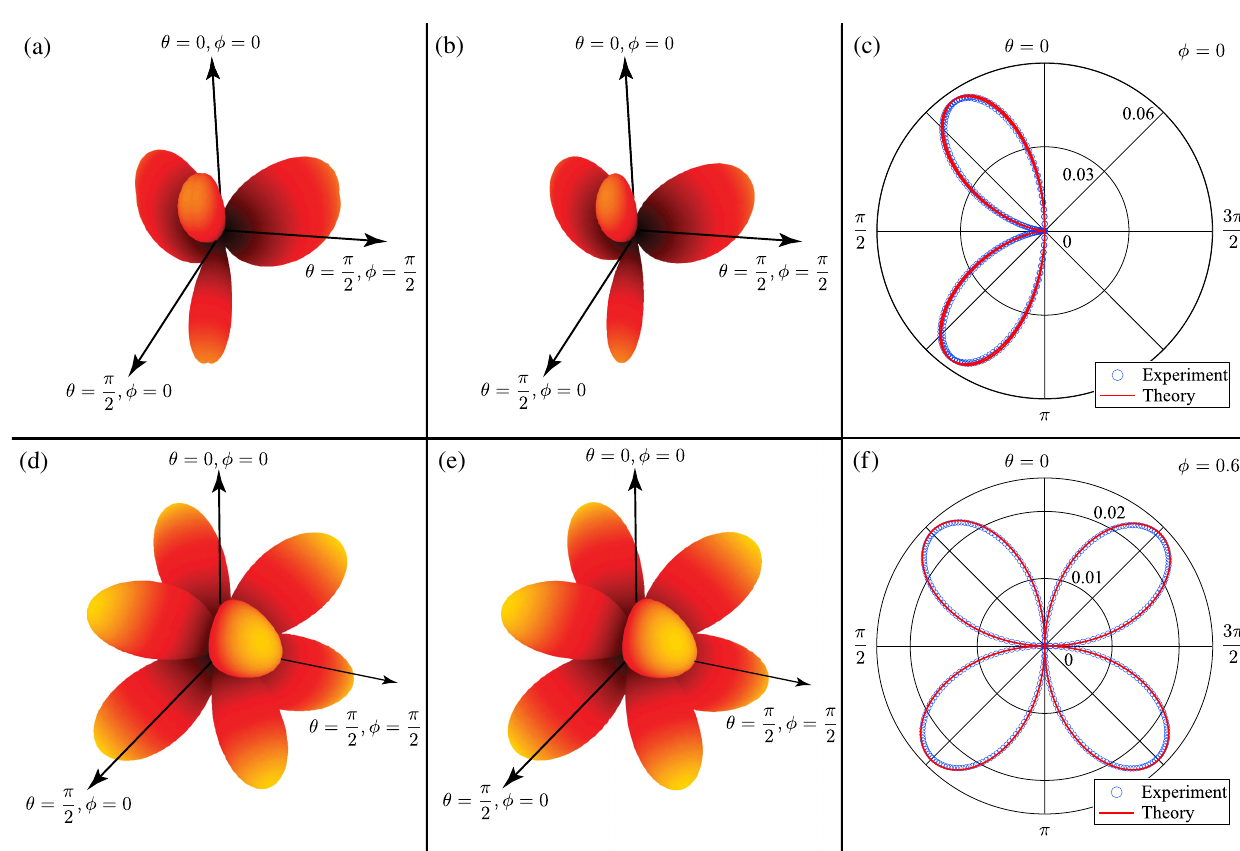
FIG. 5. Third-order correlation analysis of multimode trisqueezed states. Rows 1 and 2 show results for, respectively, the two-mode ˆ H ˆ H γ and three-mode trisqueezed states, generated by 2 M and 3 M . The spherical plots show ϕθ , which is the skewness of the generalized ˆ A ϕθ [see Eq. (6)], which mixes the mode quadratures through symplectic symmetry operations. The 6D phase multimode quadrature space of the three modes is projected into a 3D space for the purposes of visualization. Generally, γ ϕθ combines the contributions of the skewness and coskewness of the three modes involved in each case. (a) Experimental data for the two-mode case, with a maximum ˆ H skewness of 0.057. (b) The theoretical prediction for the two-mode cubic Hamiltonian 2 M . The clear agreement shows that the observed state is generated by that specific Hamiltonian. (c) A plane cut of the spherical plots through the plane at ϕ ¼ 0 . The theory curve is normalized to the maximum experimental value, but otherwise the theory has no adjustable parameters. There are no lobes apparent on the right half of the plot, because γ ϕθ is negative for ϕ ∈ ½ π = 2 ; 3 π = 2 (cid:3) , causing these lobes to overlap those of ϕ ∈ ½ − π = 2 ; π = 2 (cid:3) . (d) Experimental data for the three-mode case, with a maximum skewness of 0.024. (e) The theoretical prediction for ˆ H ϕ ¼ 0 . 61 (35°). Again, we see a clear the three-mode cubic Hamiltonian 3 M . (f) A plane cut of the spherical plots through the plane at agreement between the observed state and the target Hamiltonian. In particular, the antinodes (lobes) of γ ϕθ appear only at angles where all three modes are mixed, as expected for genuine three-mode